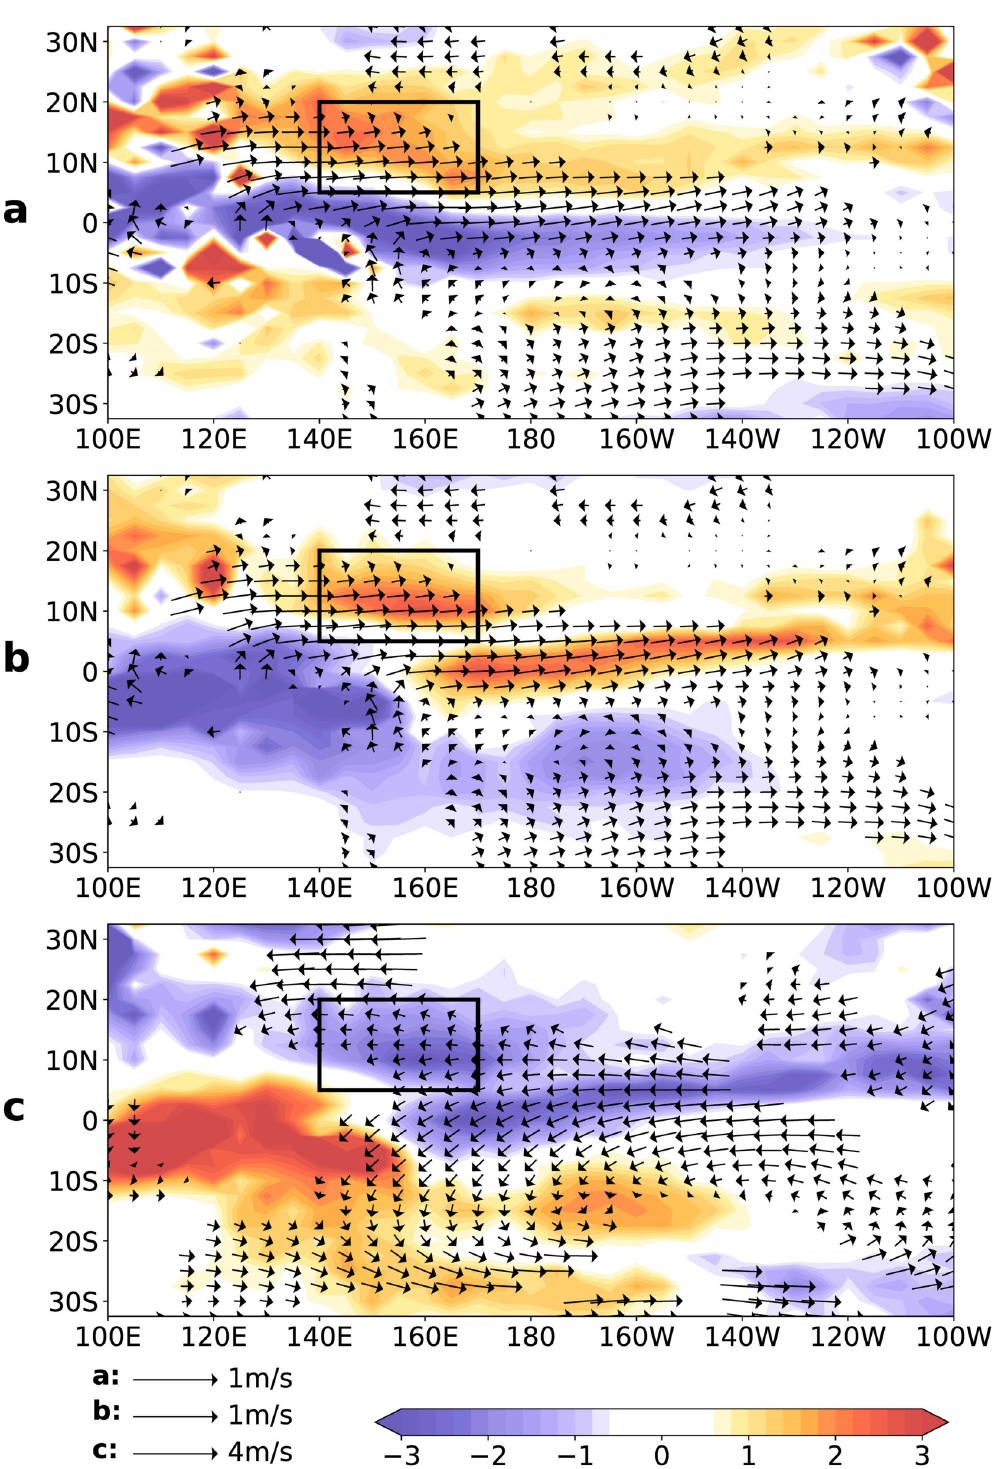
Fig 6. Composite wind speed, relative vorticity, precipitation, and the vertical movement anomaly from May to October during eight El Ni ñ o’s developing years: a, the arrow indicates the wind anomaly (m s -1 ) at 850-hPa, and the shaded area indicates the relative vorticity anomaly (5 � 10 − 5 s -1 ) at 850-hPa; b, the arrow indicates the wind anomaly (m s -1 ) at 850-hPa, and the shaded area indicates the total precipitation anomaly (mm); c, the arrow indicates the wind anomaly (m s -1 ) at 200-hPa, and the shaded area indicates the vertical movement anomaly (10 − 2 Pa s -1 ) at 500-hPa. Arrows indicates